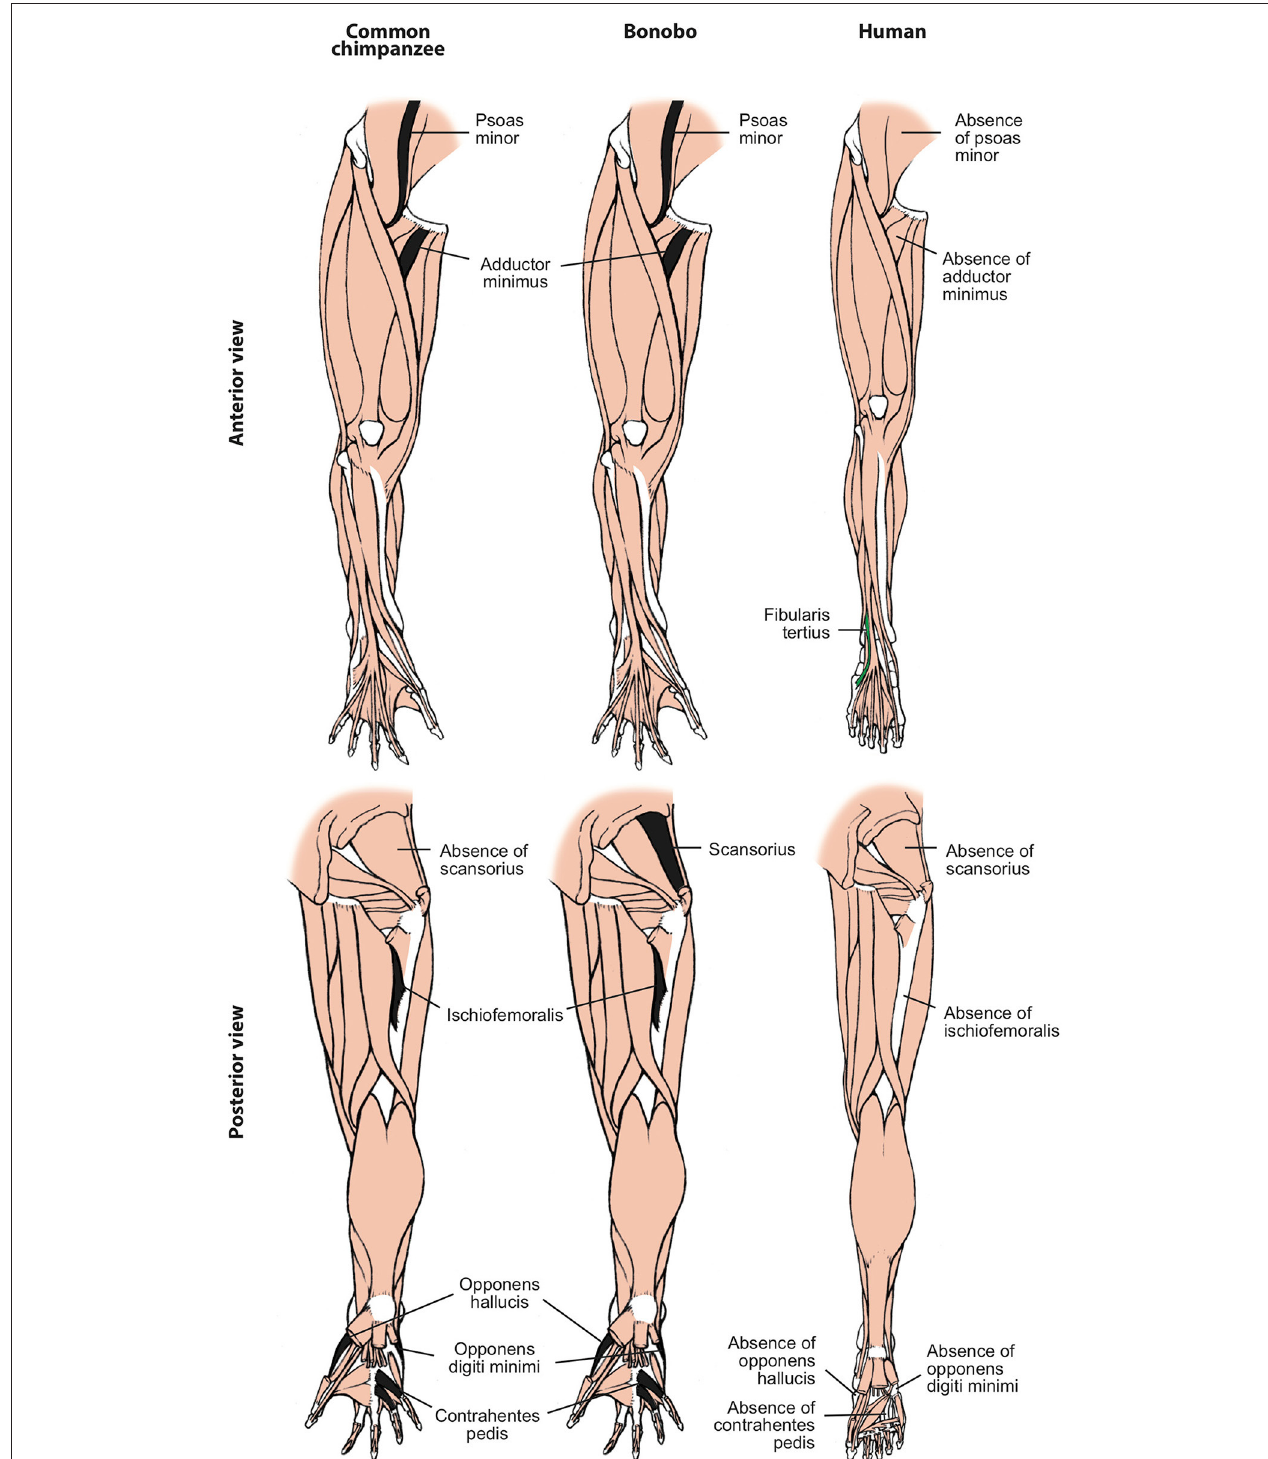
FIGURE 3 | Differences between hindlimb muscles of common chimps, bonobos and humans, based and modified from Diogo et al. (2017b). The only consistent difference between bonobos (center) and common chimps (left) concerning the presence/absence of muscles (shown in colors in the common chimps scheme) is that the latter usually lack the scansorius, as is the case in humans. In contrast, there are many differences between bonobos and humans (right) concerning the presence/absence of muscles (shown in colors and/or with labels in the human scheme; muscles present in chimps and not in humans are shown in black, in chimps). Modified from Diogo et al. (2017b); © Diogo has copyright of these figures.